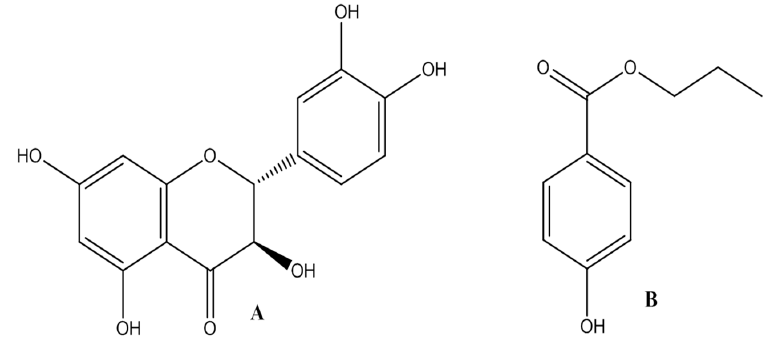
Figure 3. Chemical structures of taxifolin ( A ) and butylparaben ( B ).